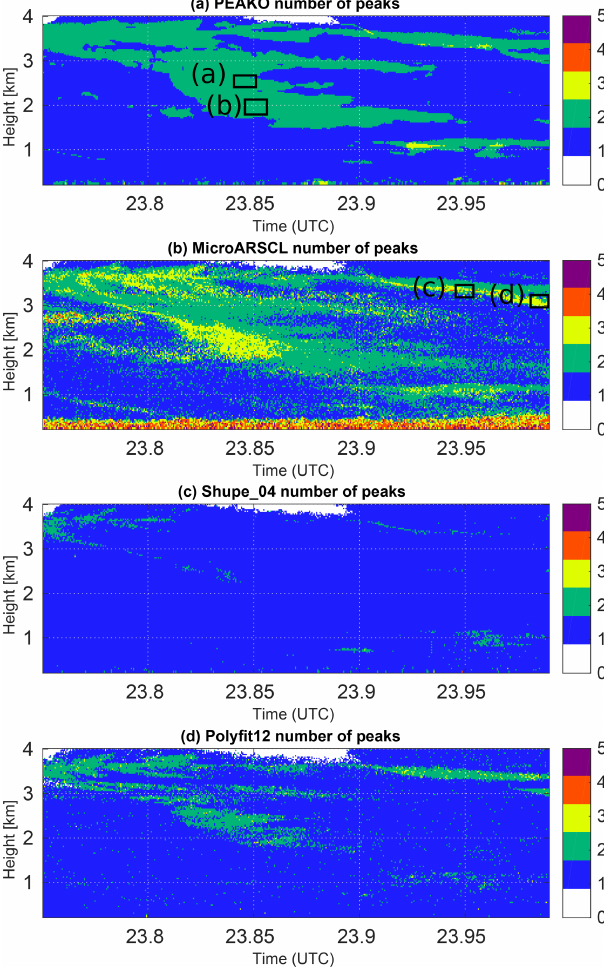
Figure C2. Like Fig. 5 but for 7 February 2014, 23.75–24UTC, at 0.2–4km